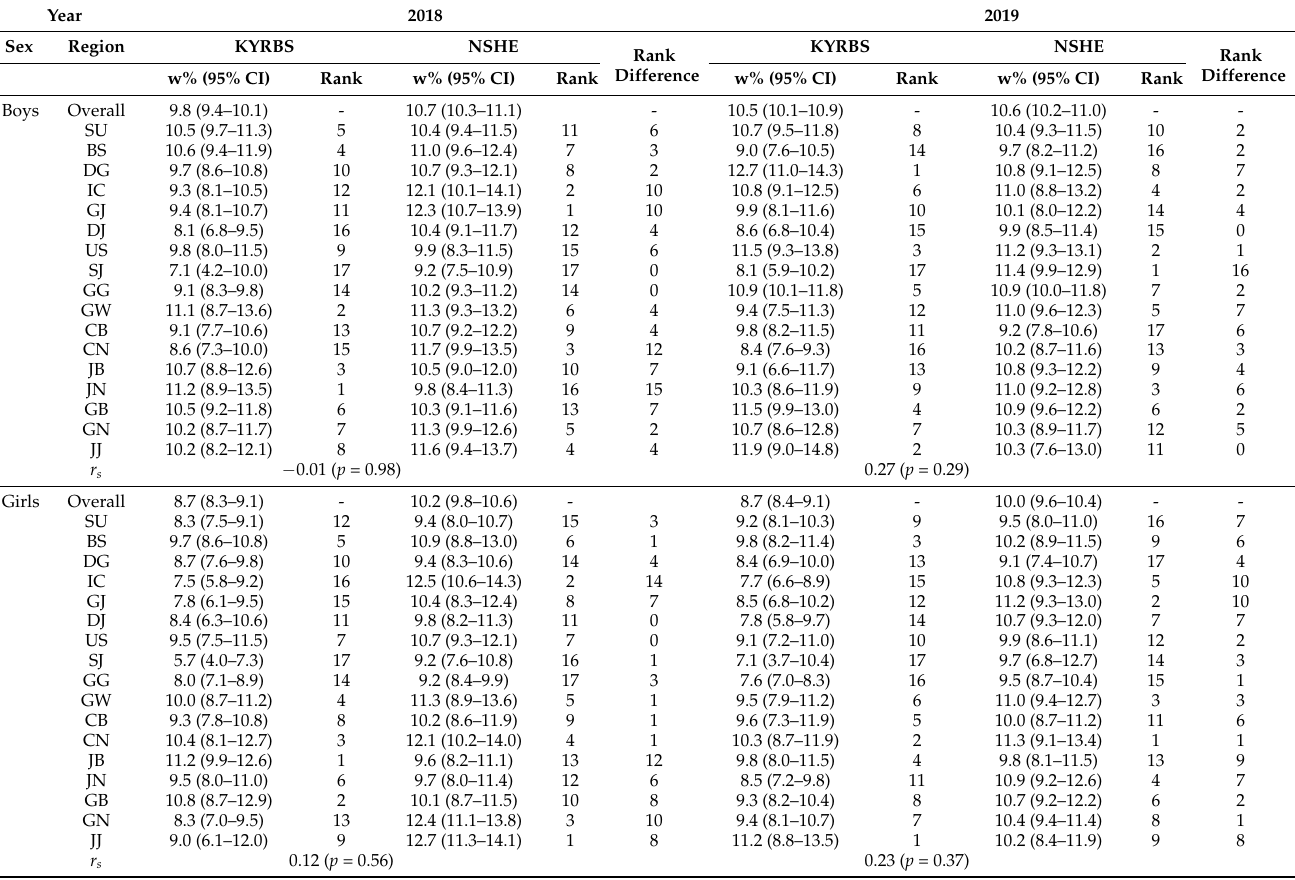
Table 3. Regional overweight prevalence and relative rankings from the KYRBS and NSHE